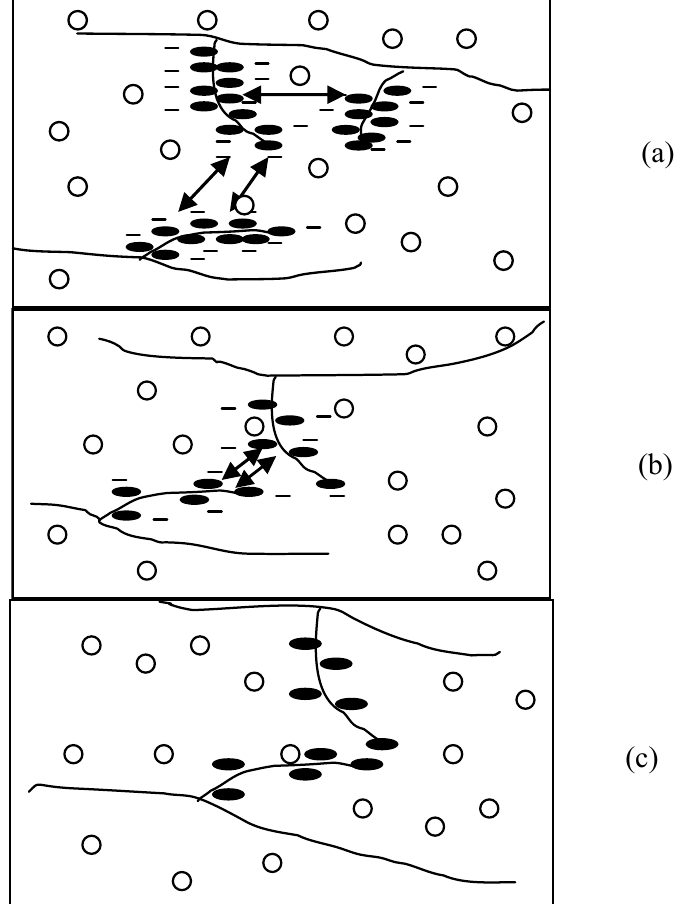
Figure 14. Molecular interaction between HPMC and surfactants molecules: ( a ) with SDeS; ( b ) with SHS; ( c ) with Triton